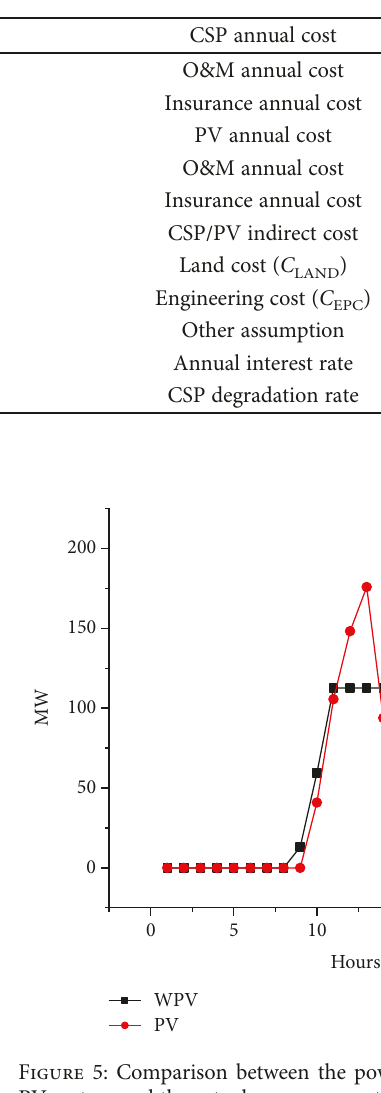
Table 5: Cost estimation of the CSP plant and PV system.